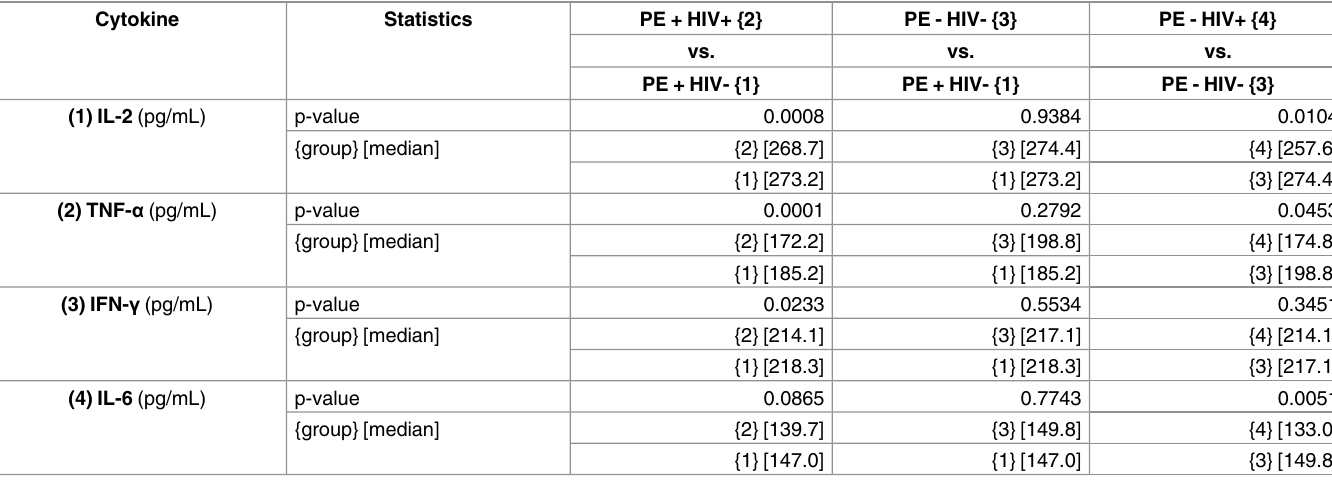
Table 2. Quantitative evaluation of cytokines.